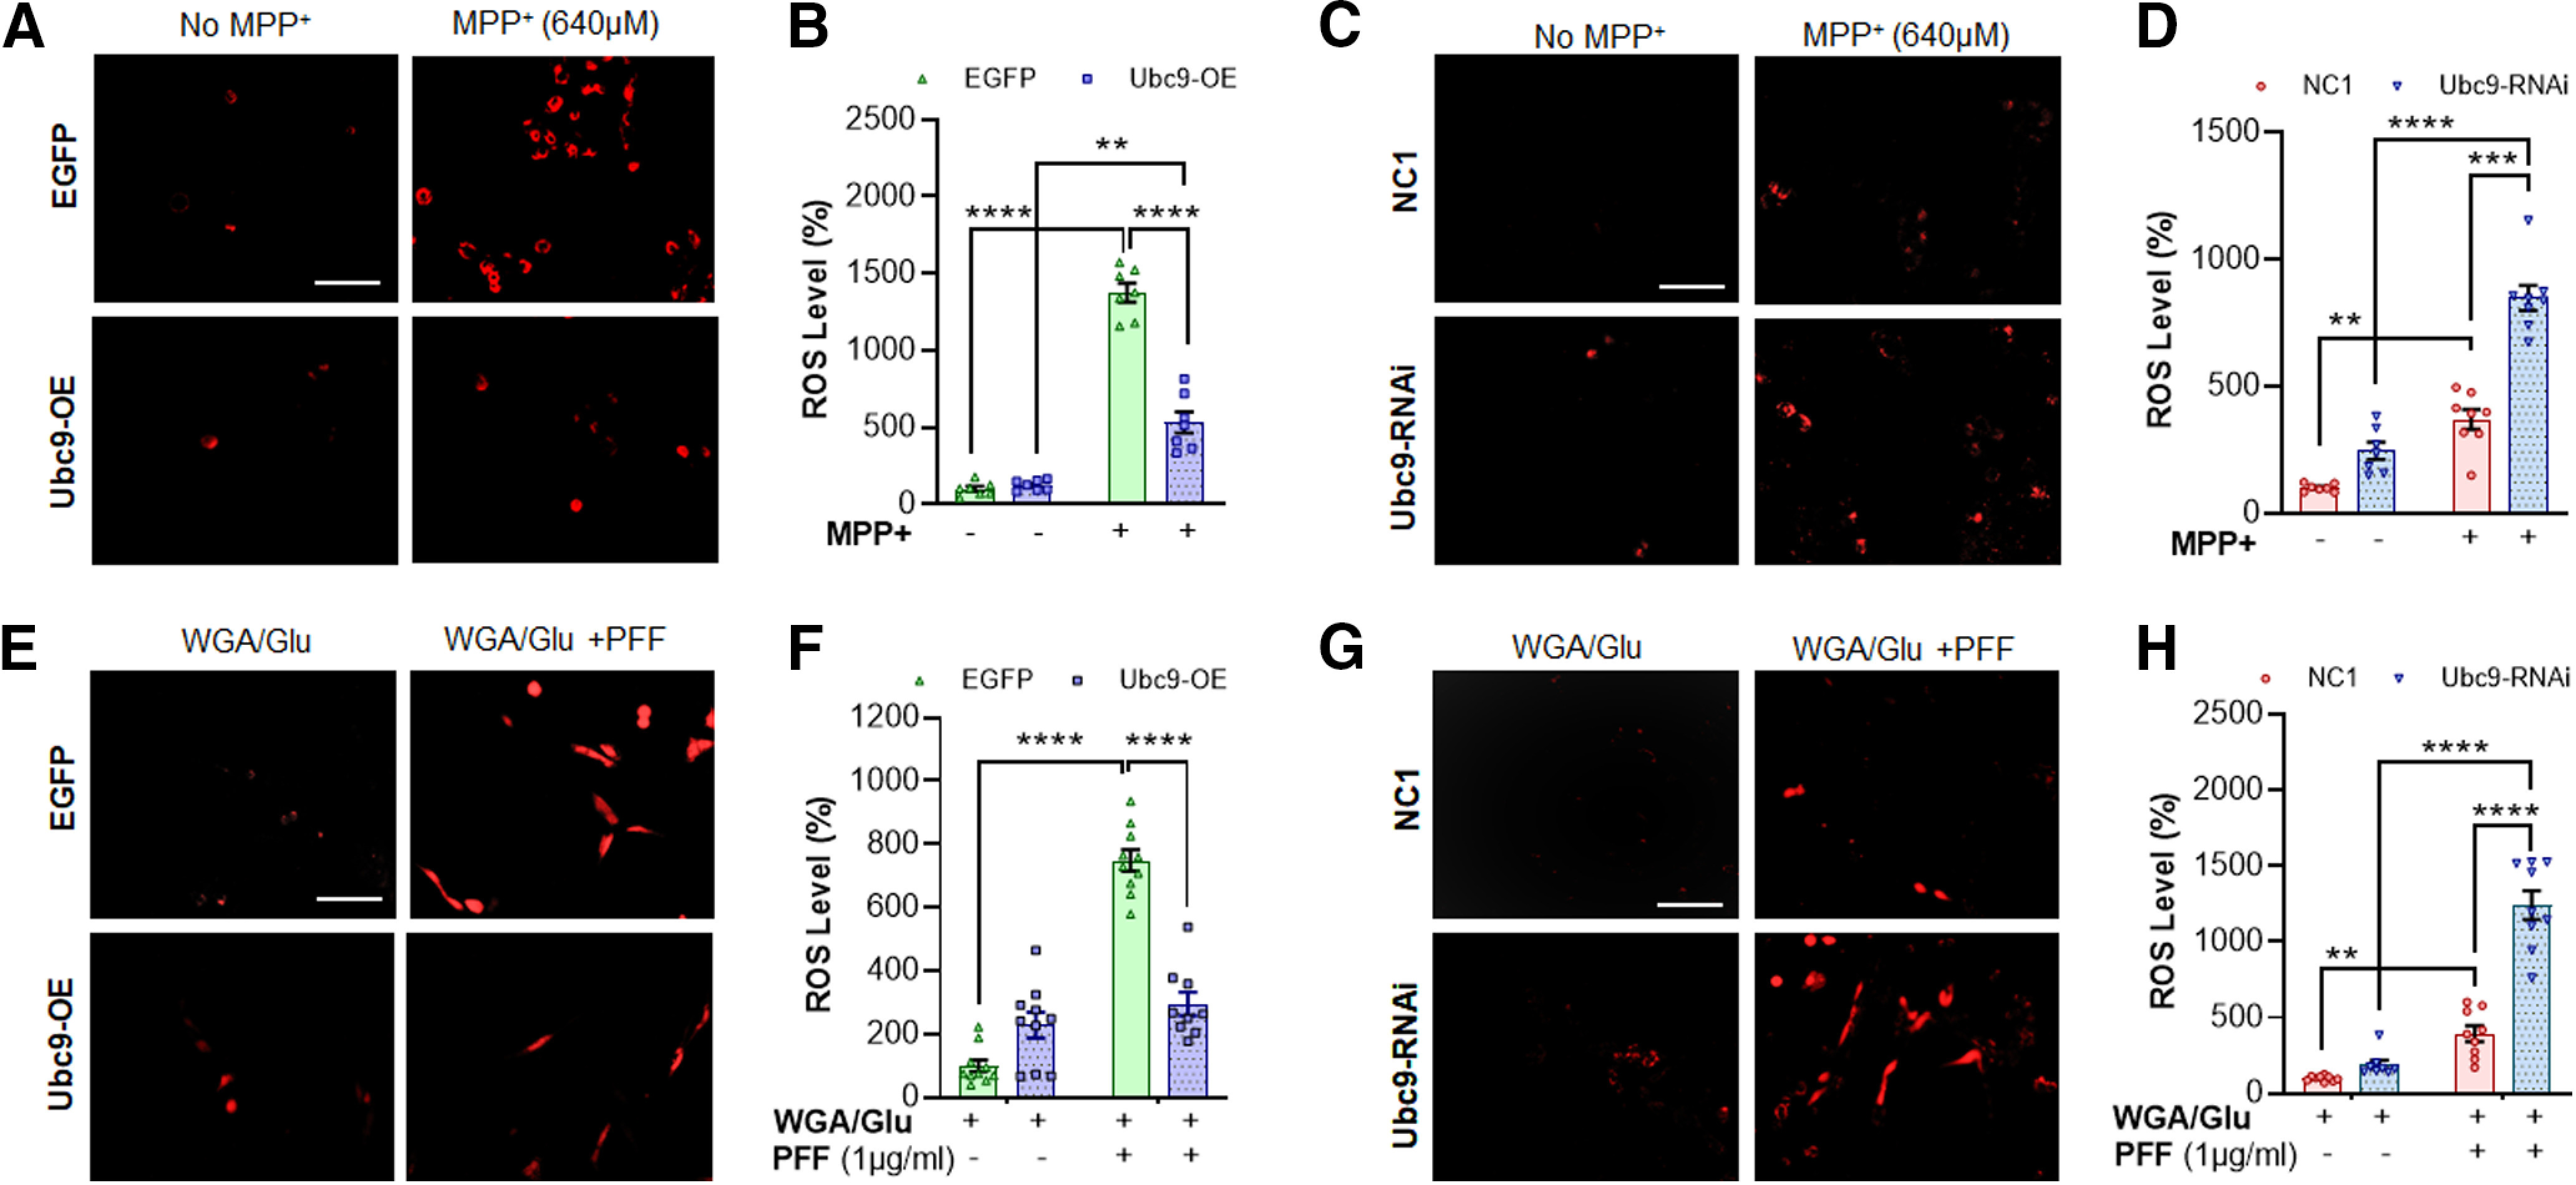
Ubc9 expression suppresses ROS generation triggered by MPP+ or PFF treatment. A, Examples of ROS-labeled cells show that MPP+ (640 μm) for 24 h stimulates the generation of ROS in N27 EGFP cells, which was labeled with CellROX red fluorescent dye in dark field microscopy. B, MPP+ triggers a striking increase in ROS generation, which was prevented by Ubc9 overexpression. C, Examples of cell images showing that Ubc9-RNAi exacerbates the ROS production induced by MPP+ exposure. D, The treatment of Ubc9-RNAi (100 pm) overnight enhances MPP+-induced ROS generation compared with NC1 random construct control. E, Cell images show that PFF (1 μg/ml) exposure for 24 h stimulates ROS production (red label) in EGFP cells, which was not clearly detected with Ubc9 overexpression. F, The ROS generation induced by PFF was almost completely suppressed by Ubc9 overexpression, compared with WGA/GluNAc control. G, Cell images show that Ubc9-RNAi exacerbates the PFF-induced ROS production, compared with no treatment or WGA/GluNAc control. H, Ubc9-RNAi significantly enhances ROS production induced by PFF treatment, compared with NC1 control. Integrated density of images was measured by ImageJ and presented in scattered dot plots. Statistical analysis was applied using two-way ANOVA followed by Tukey’s multiple comparisons post hoc test. All dot plots were displayed as individual values and mean differences are depicted as horizontal line (n = 7–10); SEM is indicated by the end of the vertical error bars; **p <0.01, ***p <0.001, ****p <0.0001 (n = 8–10 per group; n represents the average intensity of ROS in each well). Scale bar: 20 μm.